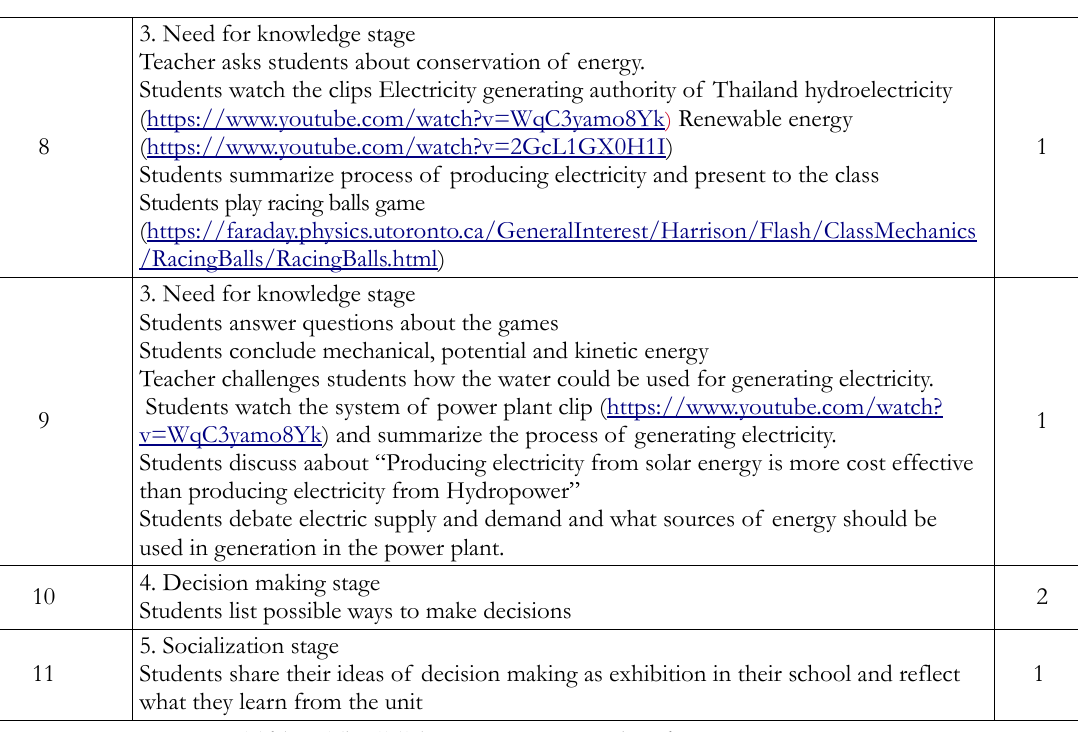
Table 2. The STS learning unit on Work and energy